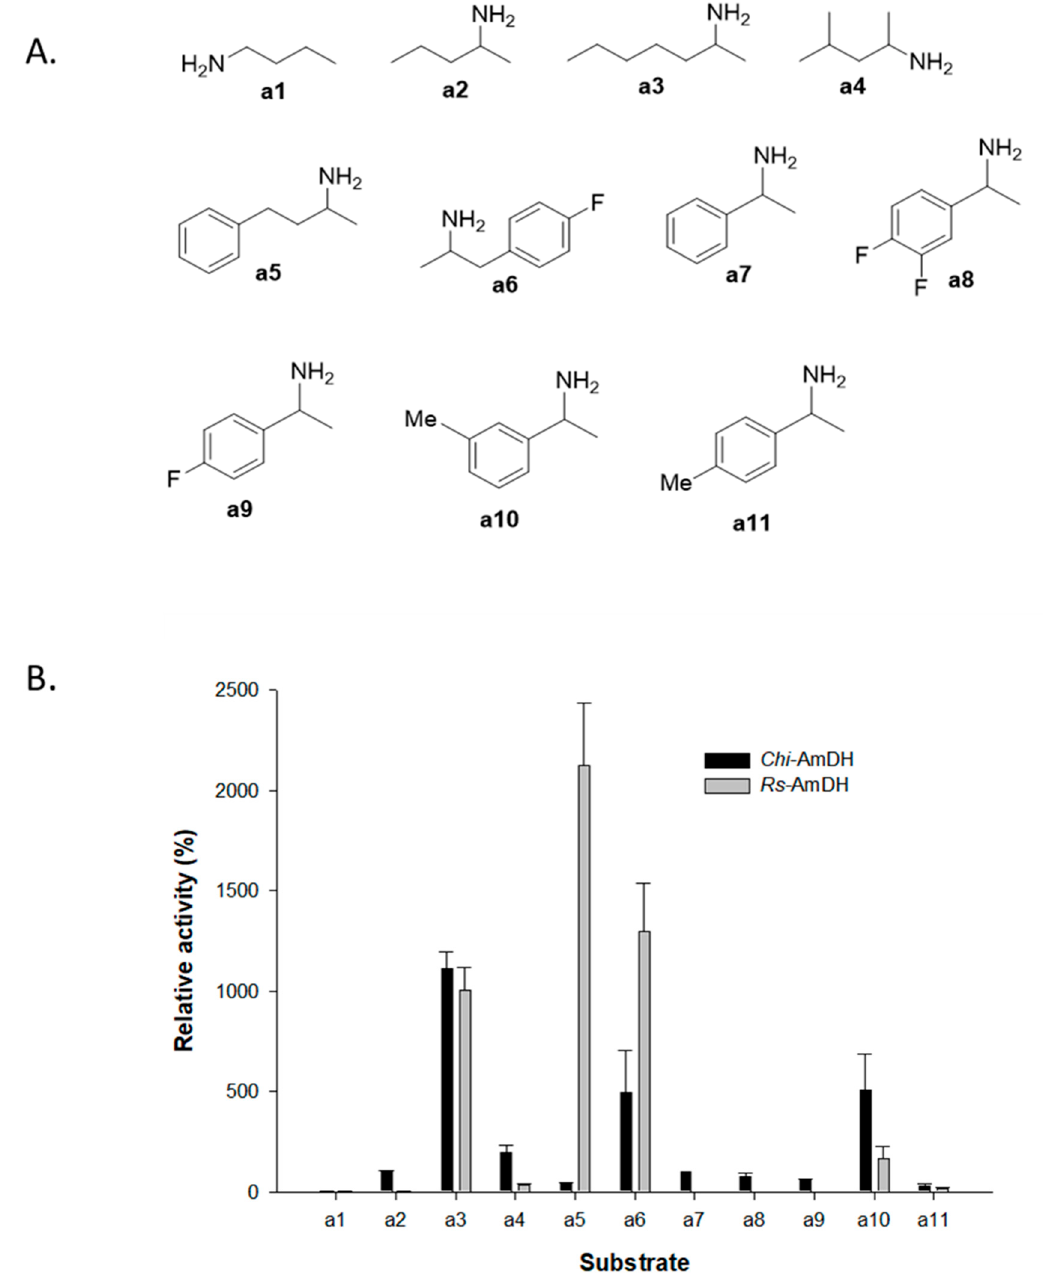
Figure 2. ( A ) Racemic amine substrates tested for the kinetic resolution by AmDH-AlaDH system; and ( B ) The oxidative deamination potential of AmDHs toward various racemic amines; Reaction conditions for oxidative deamination: 10 mM racemic amine substrate, 1 mM NAD + , 0.2 mg/mL AmDHs, 100 mM Glycine buffer (pH 10.0). 27 mU /mg activity was considered as 100%.